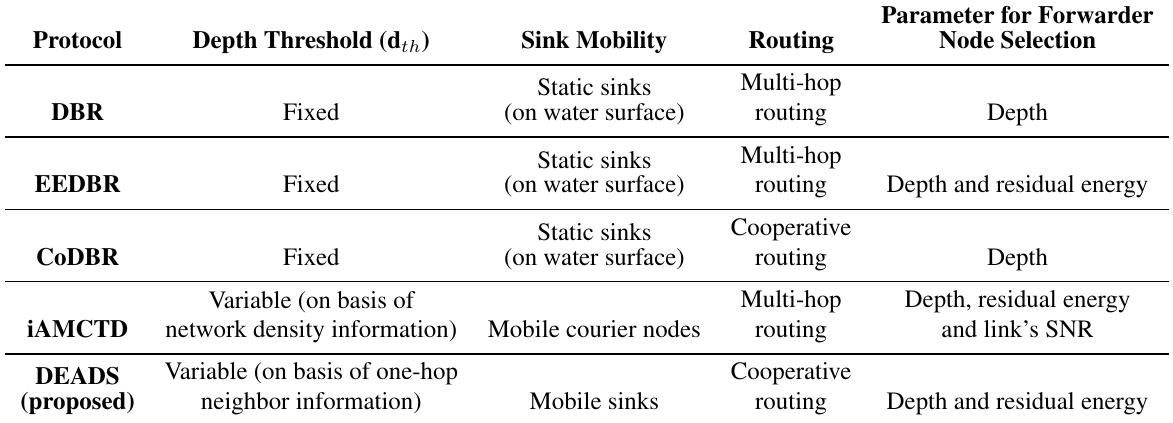
Table 1. Analysis of existing depth-based routing